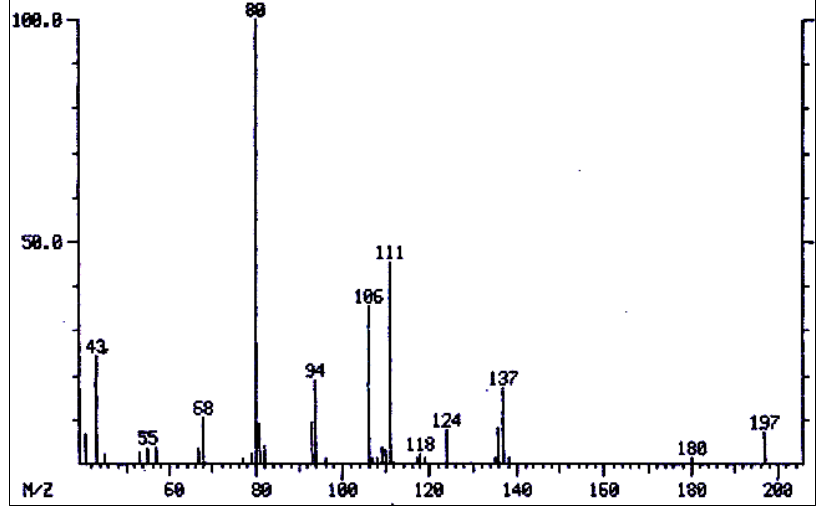
Figure 5. Mass spectrum of 7-acetylretronecine/7-acetylheliotridine.